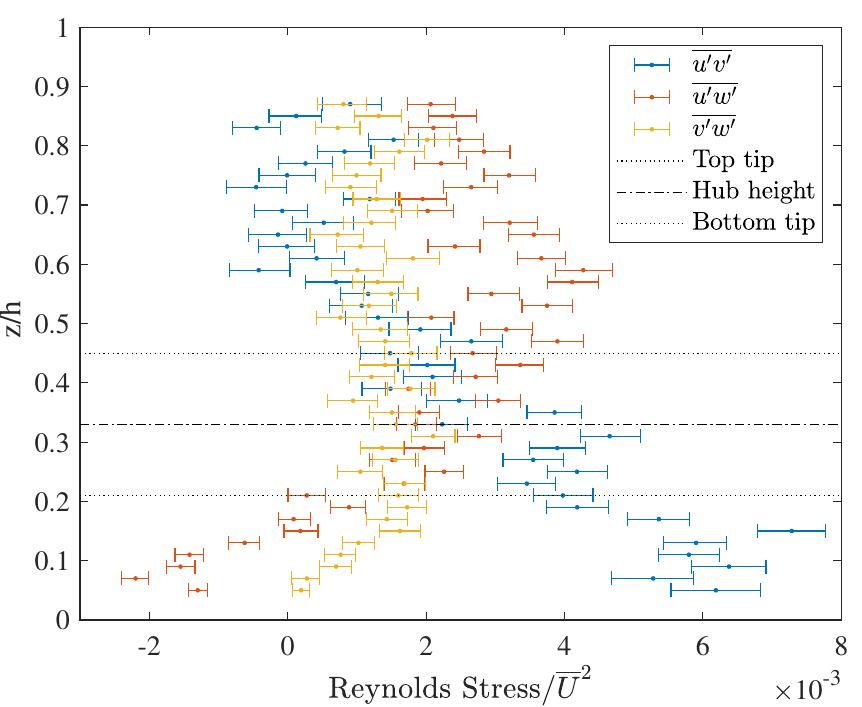
Figure 4. Mean Reynolds stress profiles in the freestream flow measured by ADV. Error bars indicate the 95% confidence interval (see Section 2.6).